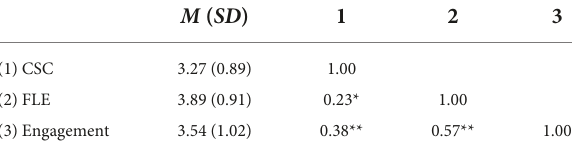
TABLE 3 Descriptive statistics and